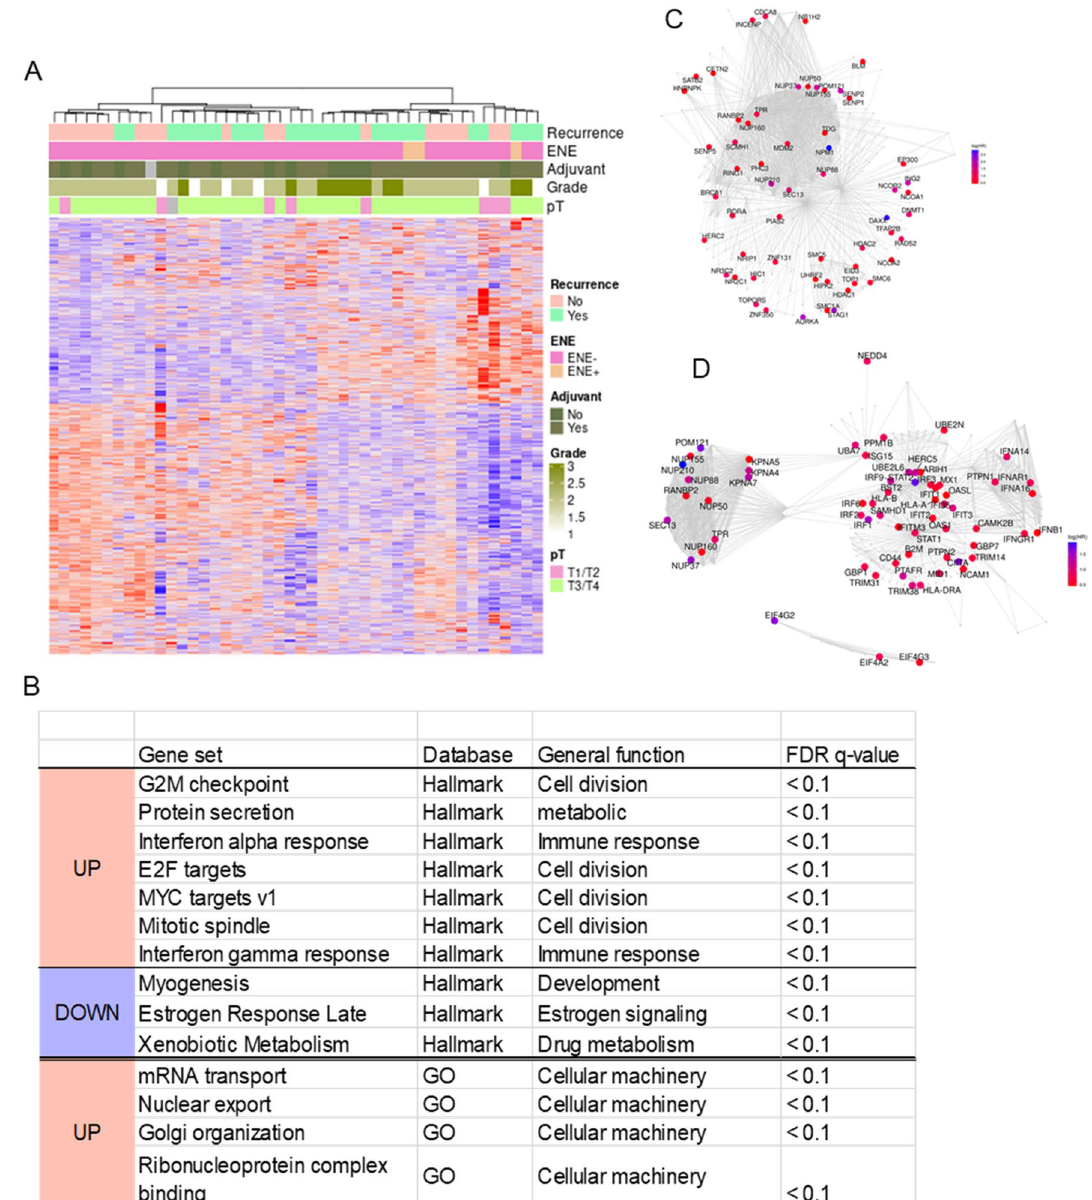
Figure 1. Transcriptional profiling to predict prognosis of ACC patients. ( A ) Heatmap for hierarchical clustering of relevant genes selected based on DFS hazard ratio ( p value < 0.05). Clinicopathologic ACC features shown in the upper panels. ( B ) Pathways enriched in patients with short DFS by GSEA with Hallmark and GO genesets. ( C , D ) REACTOME pathways for SUMOylation and Interferon Signaling. Color band displays the log (HR) value for the leading-edge genes in each